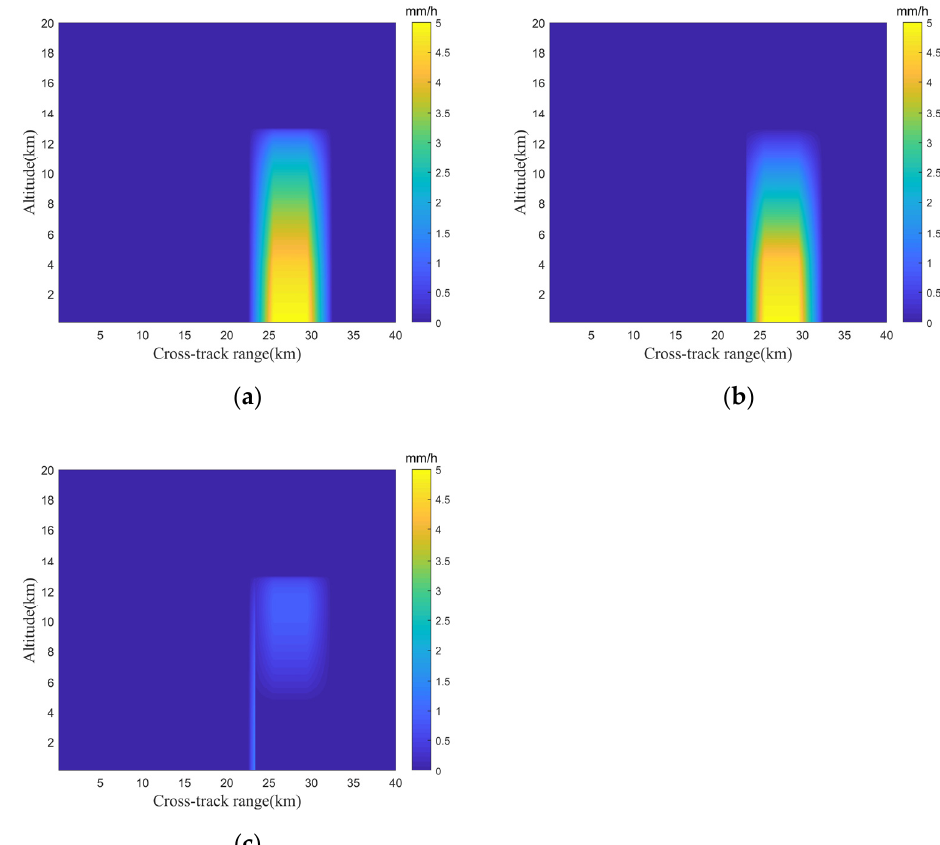
Figure 11. Two-dimensional distribution of trapezoidal rain. ( a ) The given two-dimensional distri- bution of rain; ( b ) the two-dimensional distribution of rain retrieved by MRA; and ( c ) the absolute error diagram.